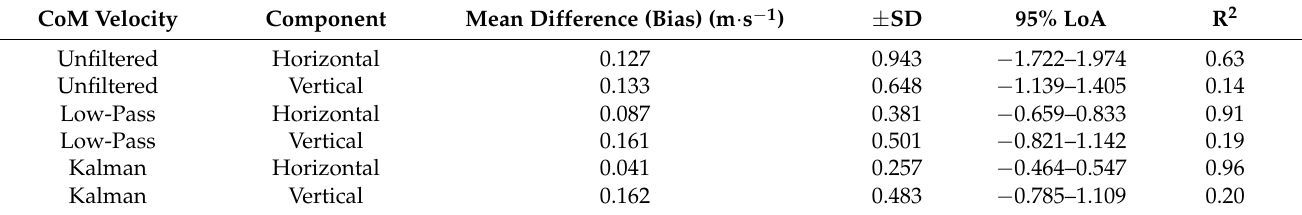
Table 2. Between system comparison of CoM velocity during sprinting.